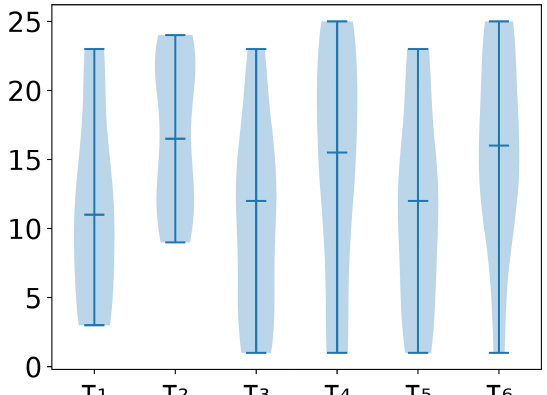
Figure A1. Distribution of coupling coefficients obtained after fit- ting the test model to the Fluxnet sites. Shown here are the distribu- tions used for generation of heteroscedastic time series.